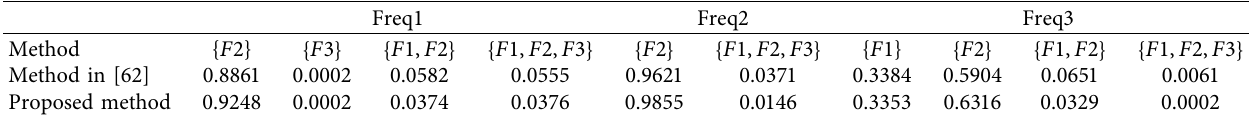
Table 10: Sensor data fusion results of different